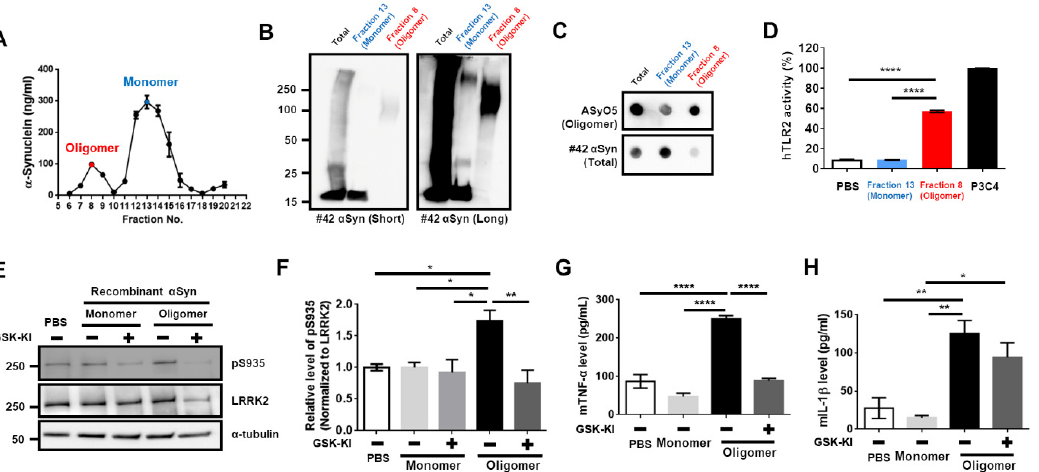
Figure 1. LRRK2 inhibitor mitigated LRRK2 activity and reduced mTNF α level that was upregulated by the TLR2-specific α Syn oligomer. ( A ) After separation of incubated α Syn pool using FPLC, the concentration of α Syn was assessed in each gel filtration fractions using sandwich ELISA. The oligomer (number 8, indicated with red-letter) and monomer (number 13, indicated with the blue letter) fractions were collected. Oligomer and monomer fractions and pre-injection mixture (Total) were subjected to Western blot ( B ) and dot-blot ( C ) analyses. ( D ) The human Toll-like receptor2 (hTLR2) activity induced by oligomer and monomer fractions was tested. PBS was used as the negative control, and P3C4 was considered as positive control. ( E , F ) After treating the cells with monomeric or oligomeric α Syn with or without the treatment with 1 µ g/mL GSK-KI (LRRK2